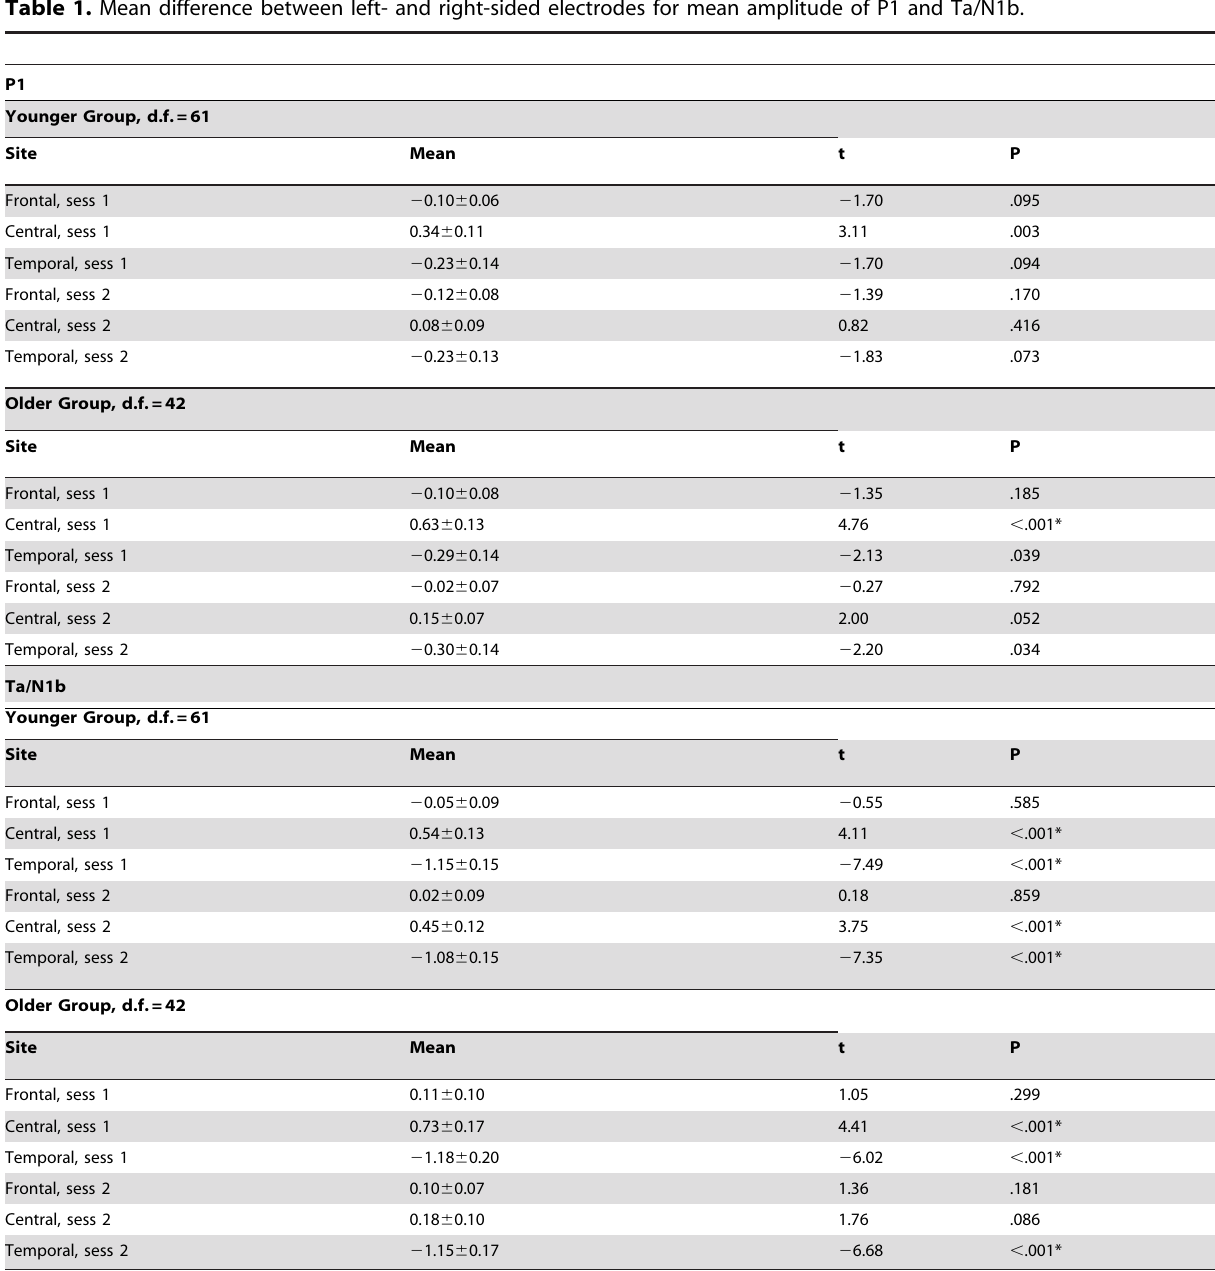
Table 1. Mean difference between left- and right-sided electrodes for mean amplitude of P1 and Ta/N1b.